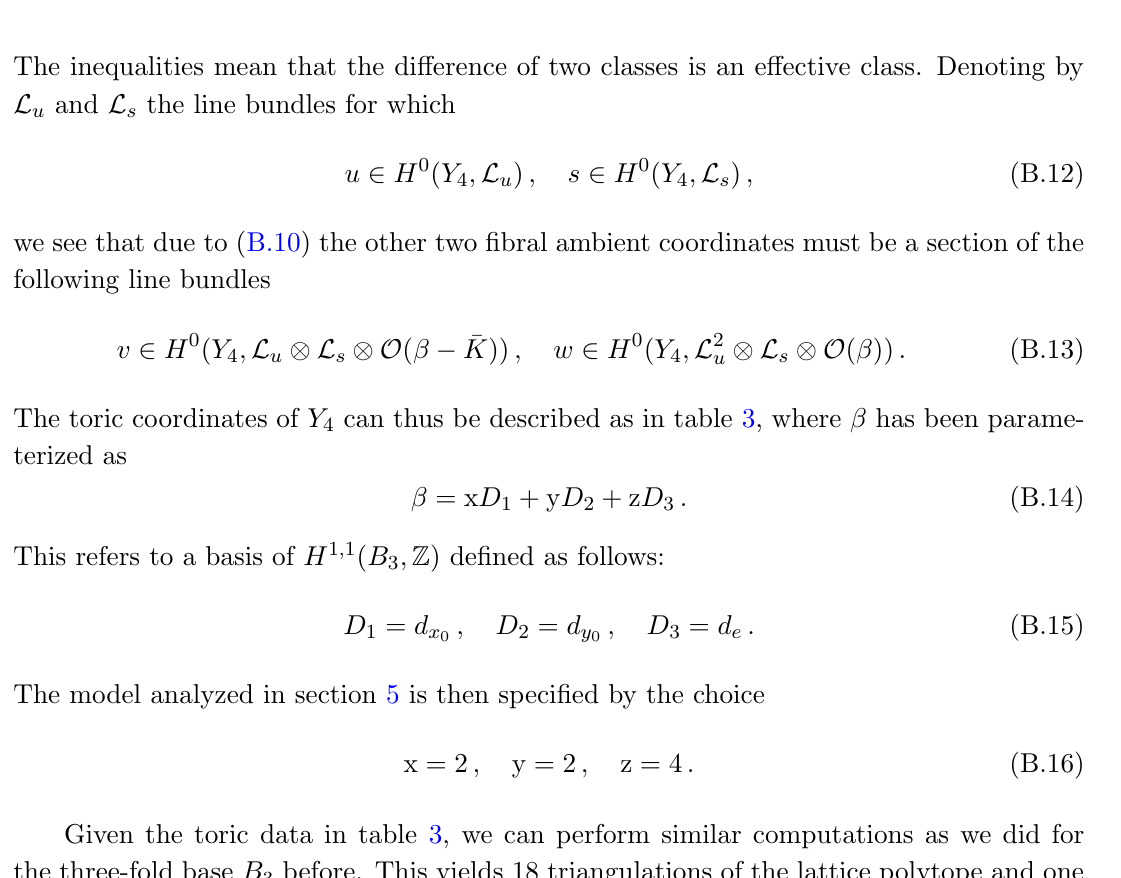
Table 3 . GLSM charges of the toric coordinates of the four-fold Y 4 that is an elliptic (cid:12)bration over the base three-fold B 3 , which by itself is described in table